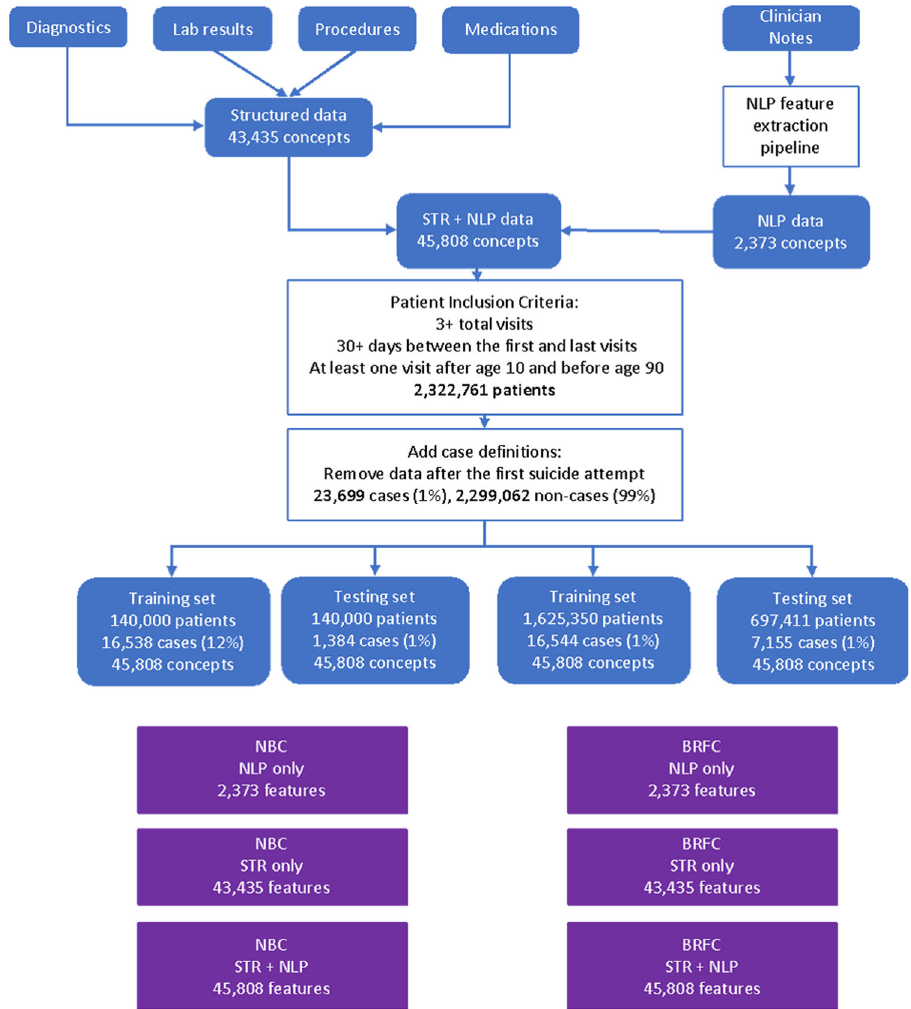
Fig. 2 Data and modeling work fl ow. The diagram describes the fi ltering and processing steps taken to arrive at the fi nal datasets used for training and testing different models described in this paper. STR — Structured Data; NLP — Unstructured data processed by Natural Language Processing; NBC — Naïve Bayesian Classi fi er; BRFC — Balanced Random Forest Classi fi